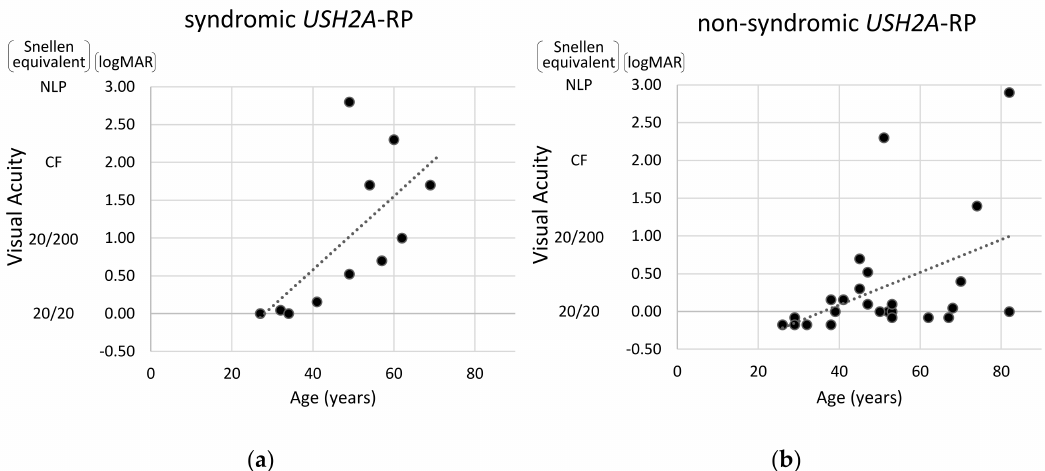
Figure 5. Scatter distribution of visual acuity and age in USH2A -RP cases. The vertical line shows visual acuity (Snellen equivalent and logMAR) and the horizontal one shows age of patient. One plot shows one patient and dash lines represent approximate straight lines. Results of 11 syndromic ( a ) and 25 non-syndromic USH2A -RP patients ( b ) are respectively presented. NLP: no light perception, CF: counting